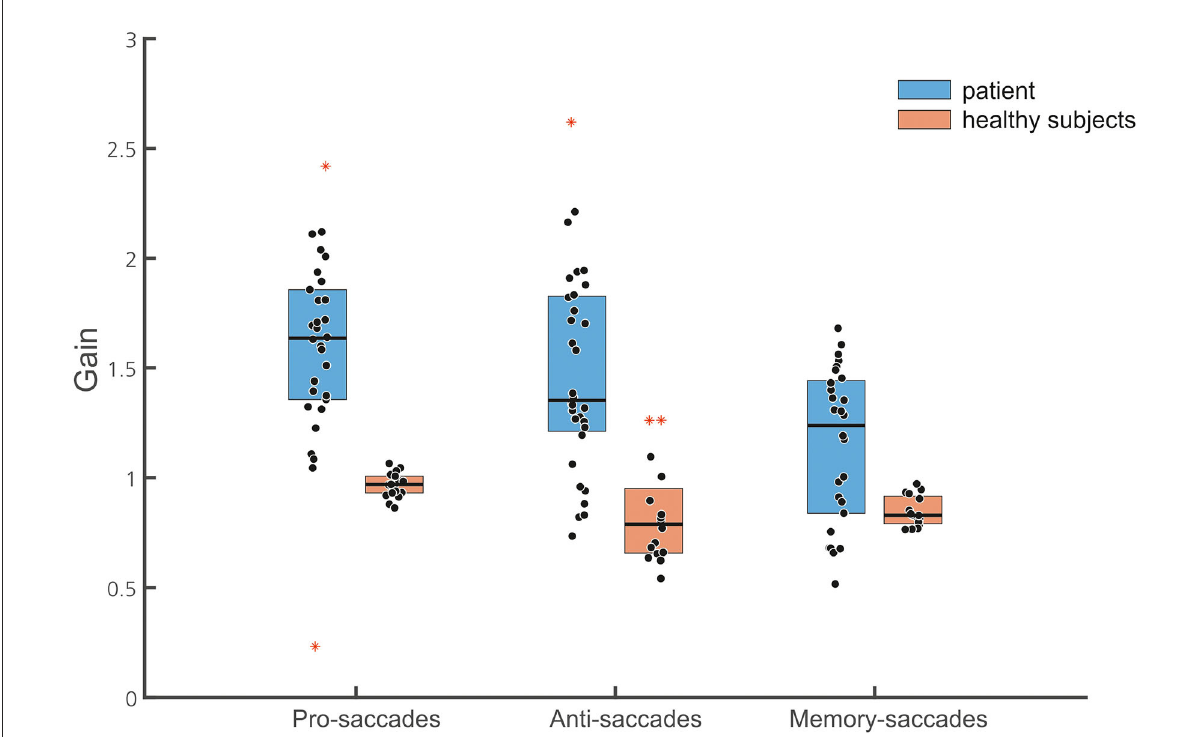
FIGURE6 Box plots of the normalized gain of the different saccade tasks are shown (30 pro-saccades, 32 antisaccades, and 28 memory-guided saccades, with marked median; upper and lower quartiles, i.e., 75th and 25th percentiles). Outliers are marked in red. Note that data points of the patient (blue boxes) indicate gain values of single saccades while they represent the mean of the normalized gain of individual subjects in the healthy subject group (brown box). The median gain of all three saccade tasks is larger in the patient than in the healthy